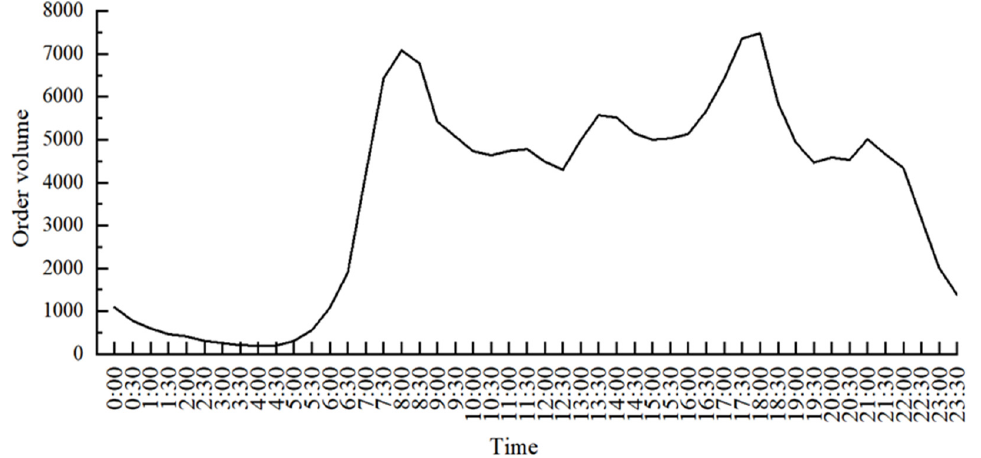
Figure 2. Changes in the average daily order volume of online car hailing.